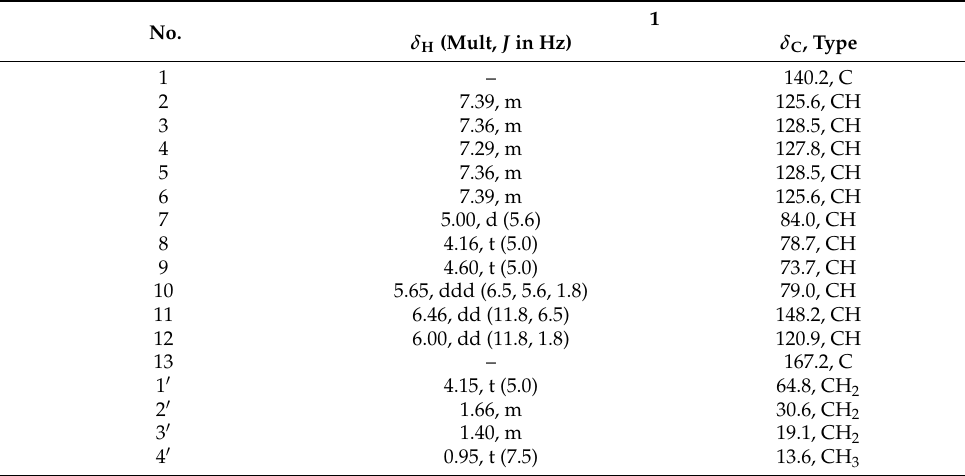
Figure 2. Key COSY (bold), HMBC (arrow), and NOESY (double arrow) correlations of 1 ‒ 3 . Table 1. 1 H NMR (600 MHz) and 13 C NMR (150 MHz) spectroscopic data of 1 in CDCl 3 . 1 No. δ H (Mult, J in Hz) δ C , Type 1 –